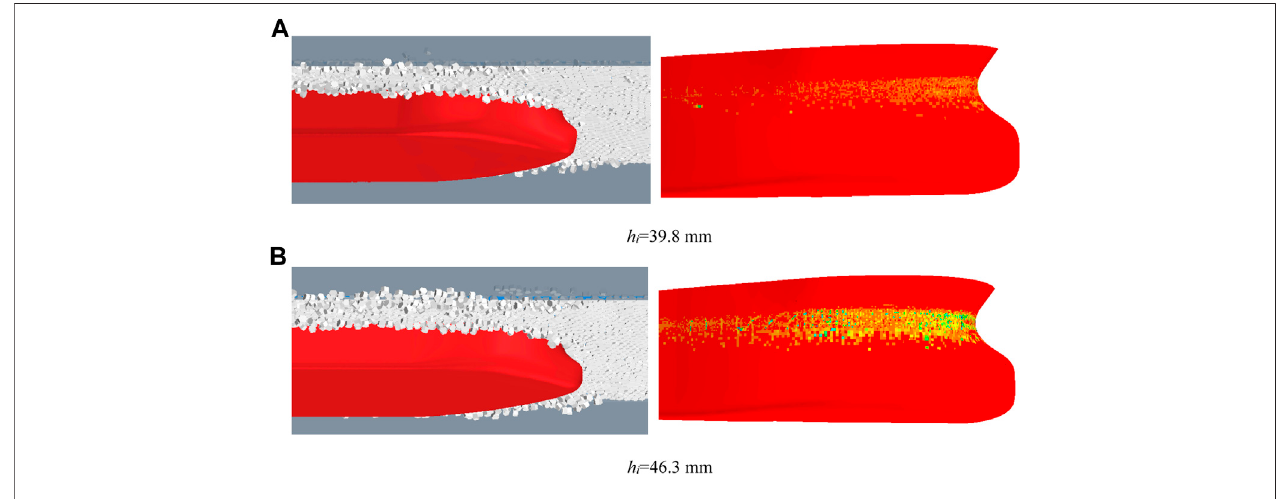
FIGURE 11 | Brash ice accumulation and contact force on the